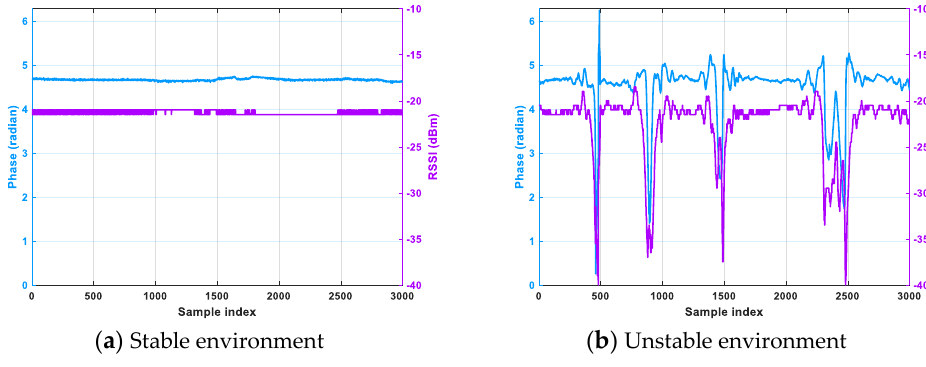
Figure 3. Phase and RSSI in stable and unstable environments.